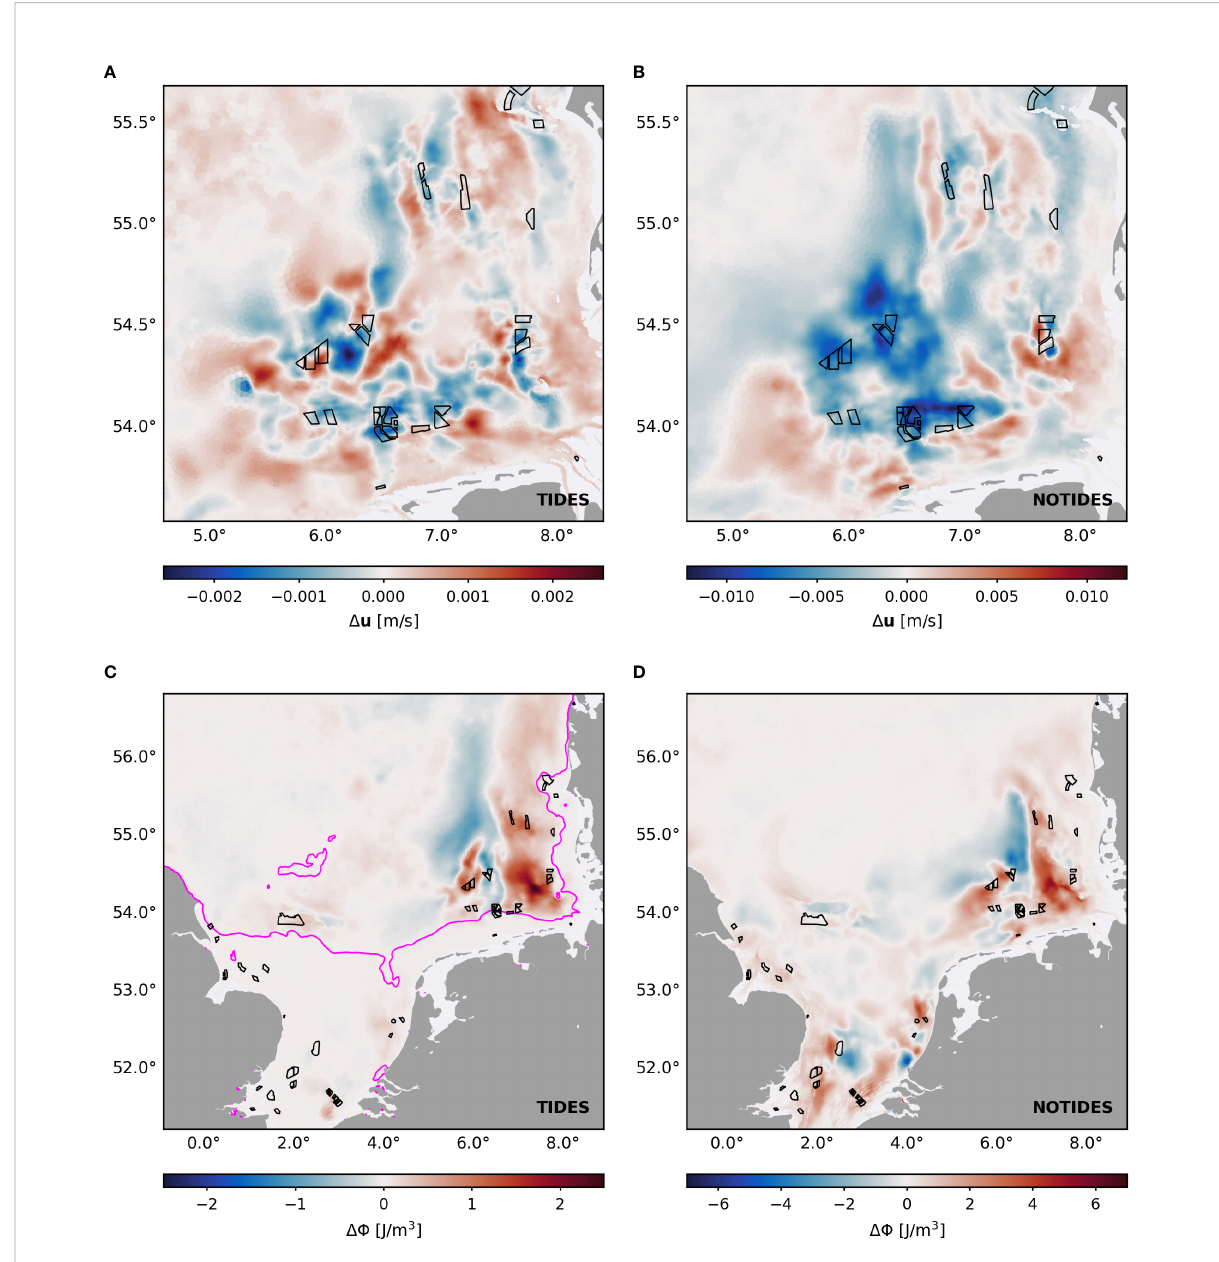
FIGURE 7 Regional mean wake effects on surface velocity u (A, B) and potential energy anomaly F (C, D) in TIDES (left) and NOTIDES (right). Monthly mean changes are depicted for the simulation period between May and September 2013. Magenta line in (C) indicates the mean tidal mixing fronts in TIDES . Black polygons indicate the offshore wind